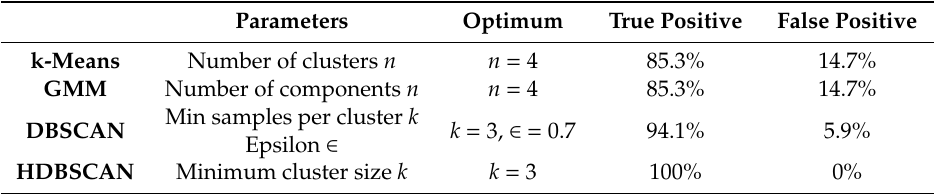
Table 2. Result comparison of applied unsupervised approaches.